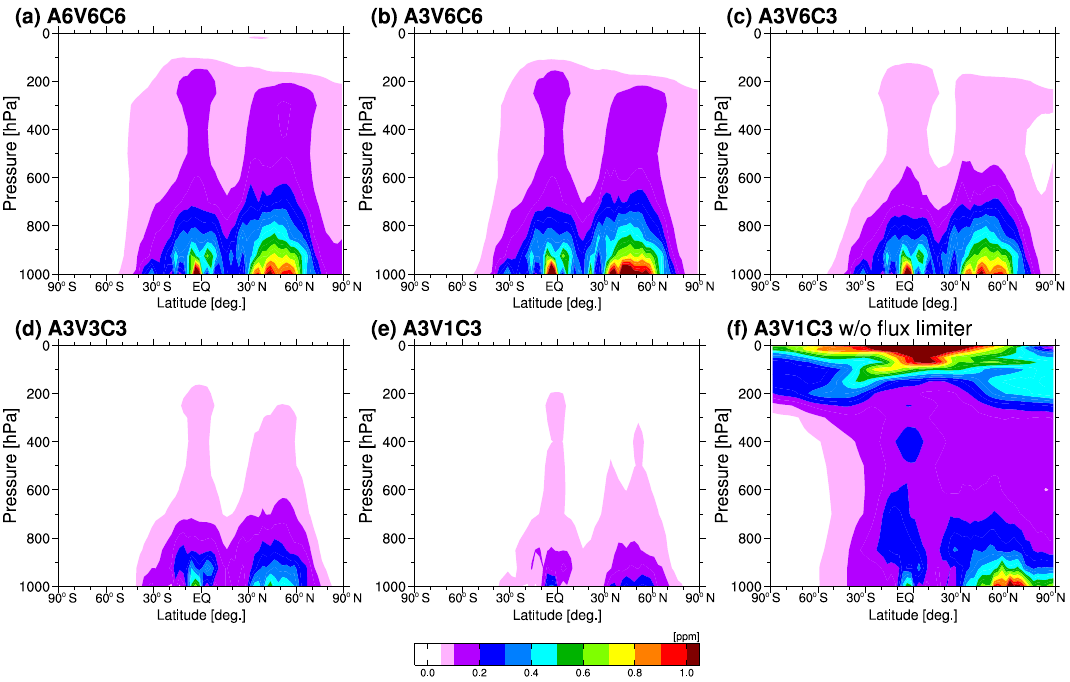
Figure 2. Zonal-mean latitude–pressure cross-section of annual root-mean-square deviation (RMSD) of CO 2 concentration simulated by the offline model against the online model. Time interval of the meteorological driver data is changed for each transport process as shown in Table 2 (a–e) and the same time resolutions are used as (e) but with the flux limiter switched off (f) . Table 2. Temporal intervals for advection, vertical diffusion, and cumulus convection processes in each sensitivity test and relative errors globally averaged at the surface and 300hPa. The relative error is calculated at each model grid by dividing RMSD by the standard deviation of the CO 2 concentration variation simulated by the online model for